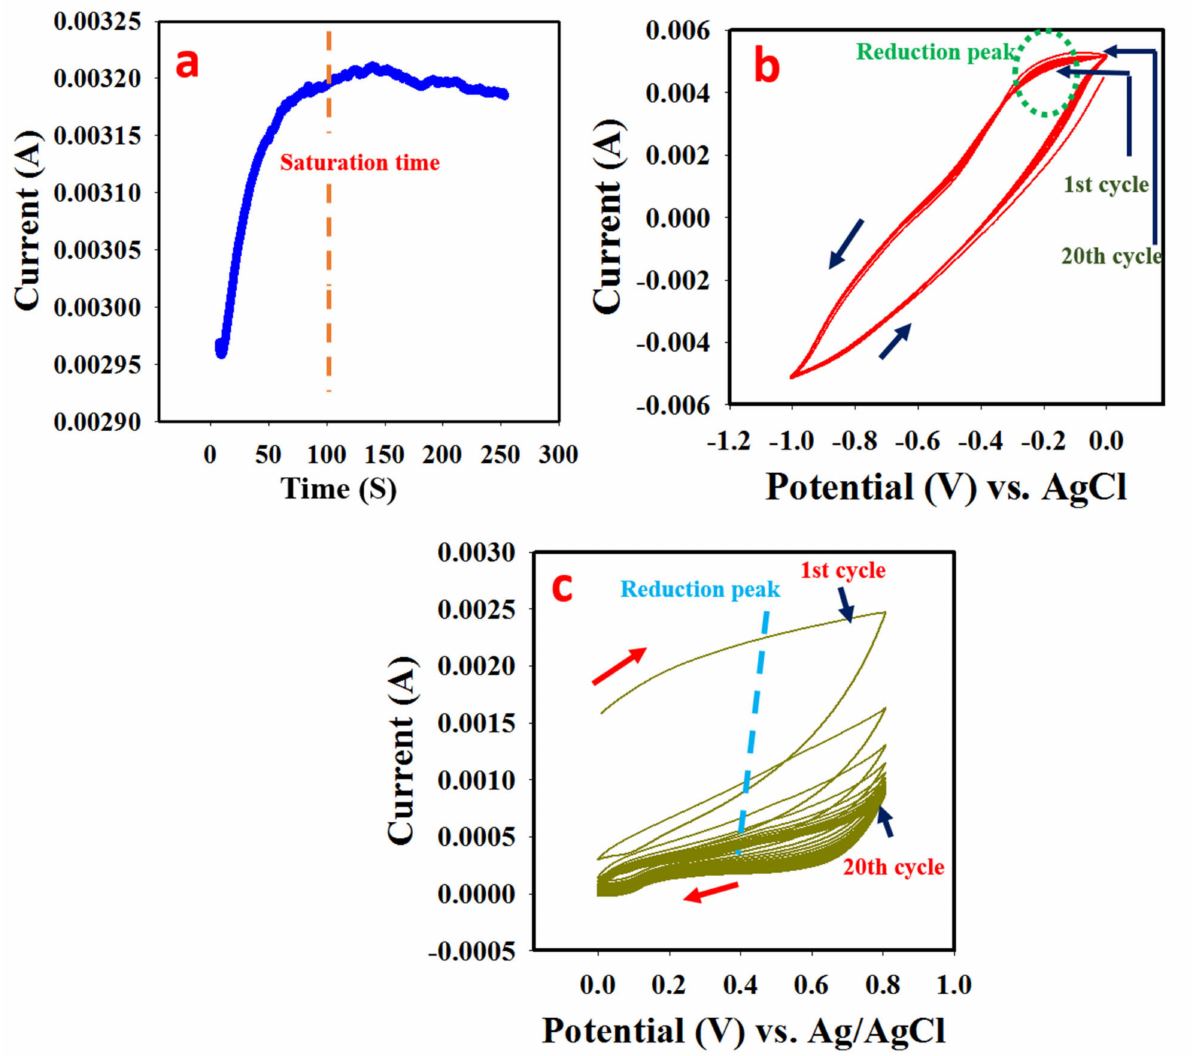
Figure 1. ( a ) Chronoamperogram obtained during synthesis of PANI at a constant potential of 1.0 V. ( b ) Cyclic voltammogram obtained during deposition of MnO on PANI coated GCE in a solution containing 0.1 M MnSO 4 /0.1 M KNO 3 at a scan rate of 75 mV/s. ( c ) Cyclic voltammogram obtained during deposition of BaO on PANI − MnO coated GCE in a solution containing 0.1 M Ba(NO 3 ) 2 /0.1 M KNO 3 at a scan rate of 75